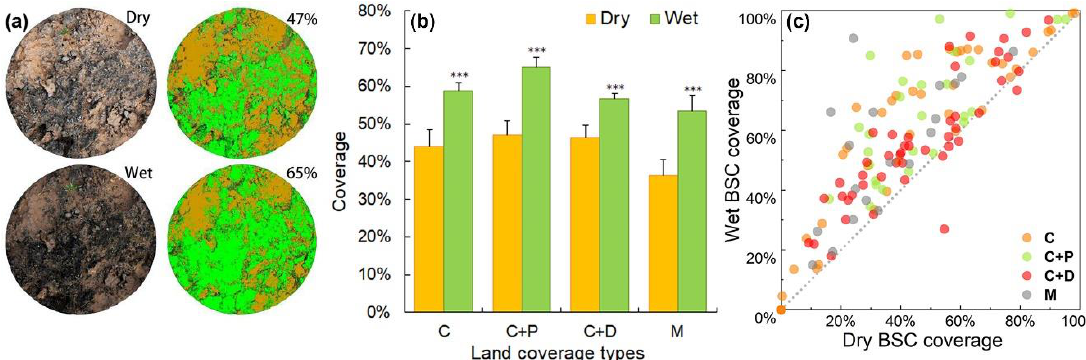
Figure 5. Estimation of BSC coverage in dry and wet conditions. ( a ) One pair of points out of 136 plots with two repeated measures (in dry and wet conditions); ( b ) BSC coverage in dry and wet conditions for different coverage types, C: BSCs; C+P: BSC with plants; C+D: BSC with dead wood; and M: BSC mixed with both plants and dead wood; error bars indicate the standard error (SE); “***” indicates significant differences between means under dry and wet conditions at P < 0.001; and ( c ) scatter plot of each pair of BSC coverage points in dry versus wet conditions in C (orange points), C+P (green points), C+D (red points), and M (gray points) cover types. The gray dotted line represents y = x.